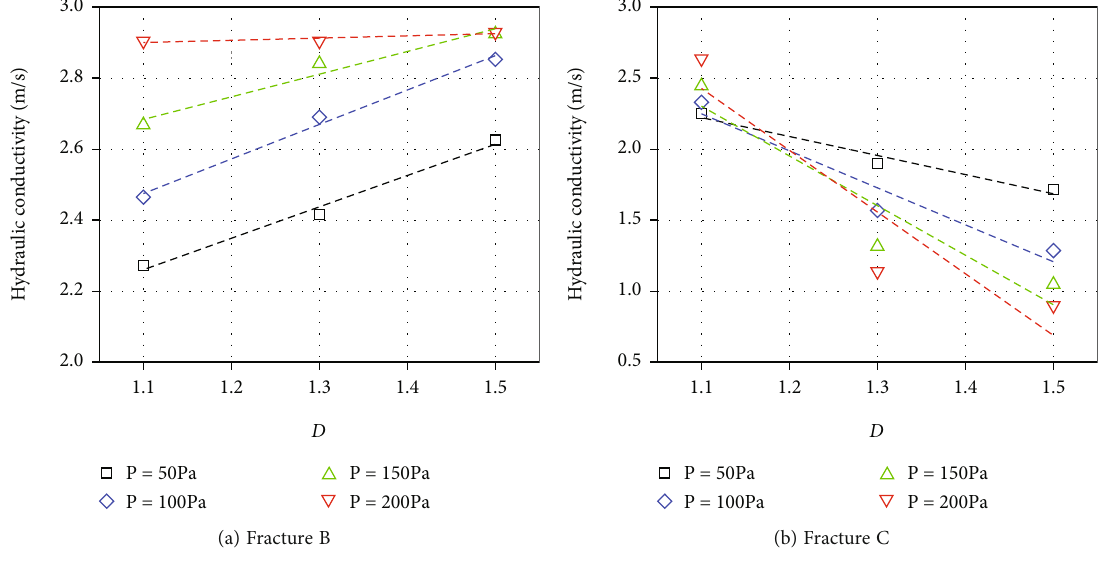
Figure 11: Evolution of hydraulic conductivity with fractal dimension.